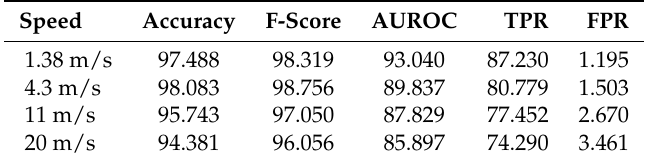
Table 2. Host-based detection performance per network mobility (Network of 50 nodes). AUROC—area under the curve of the receiver operating characteristic, TPR—true positive rate, FPR—false positive rate.